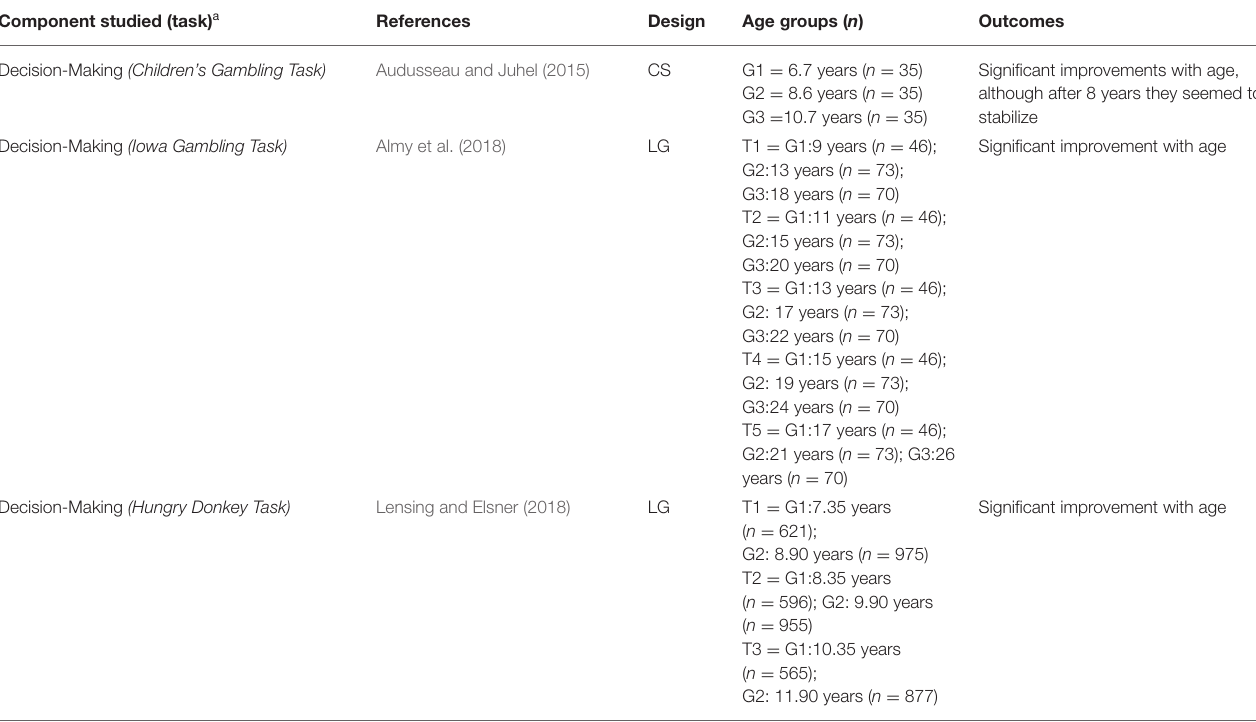
TABLE 4 | Studies on the development of the decision-making ( n = 3).